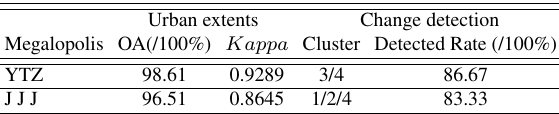
Figure 3. (a) Bi-dimensional scatterplots of the clusters extracted in the second layer of the hierarchical clustering procedure; (b)change pattern mapping of the 4-component clusters. Table 3. Validation of urban extents and recognized clusters.